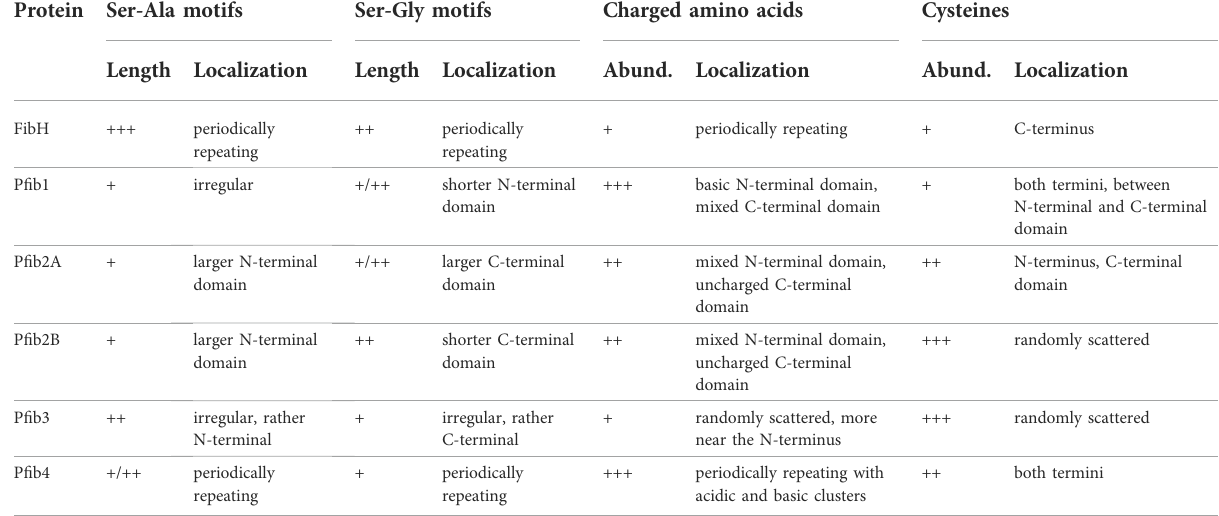
TABLE 4 Comparison of fi broin heavy chain and pseudo fi